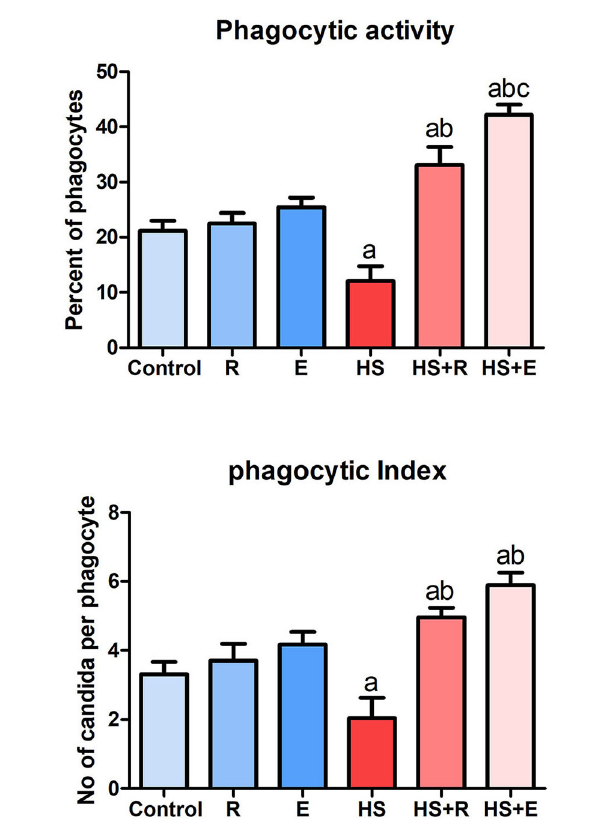
FIGURE 1 | Phagocytic activity and index of broiler chicks.